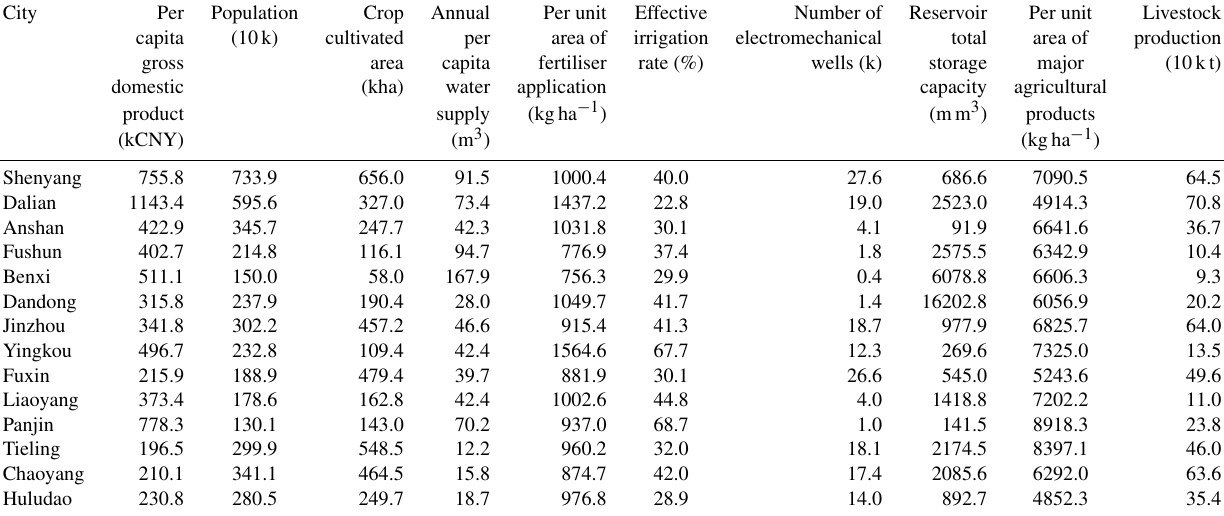
Table 2. Vulnerability factors for each city in Liaoning province collected from the 2017 Liaoning Statistical Yearbook (Liaoning Province Bureau of Statistics,